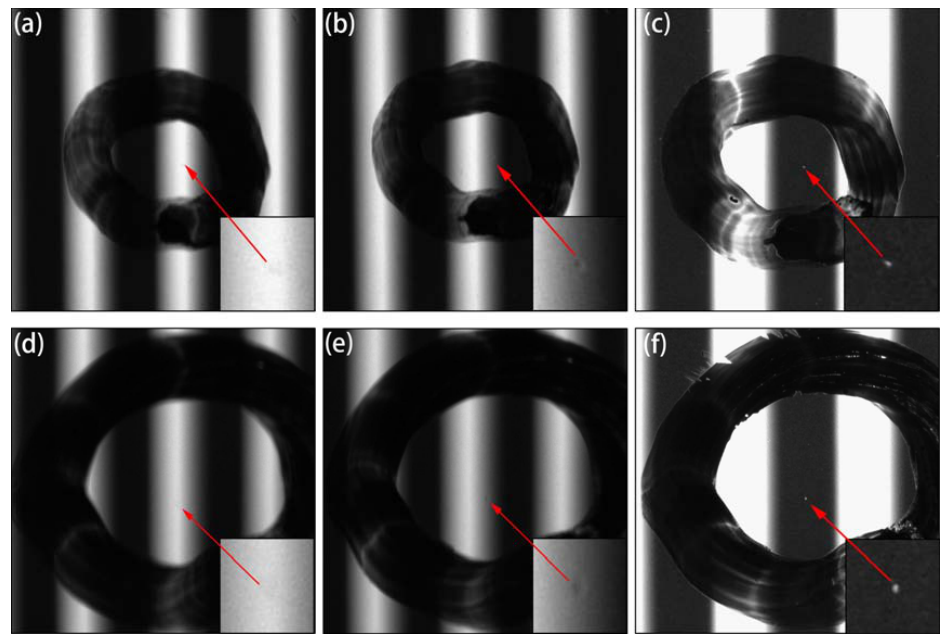
Figure 3. Defect images of two samples with various illumination levels: ( a , d ) defects with structured light illumination; ( b , e ) defects with edge ‐ of ‐ light illumination; ( c , f ) defects with saturated imaging technique. ( a – c ) were Sample 1 with a transparent impurity defect; ( d – f ) were Sample 2 with an indentation defect. The size of the defects was approximate 100 μ m.